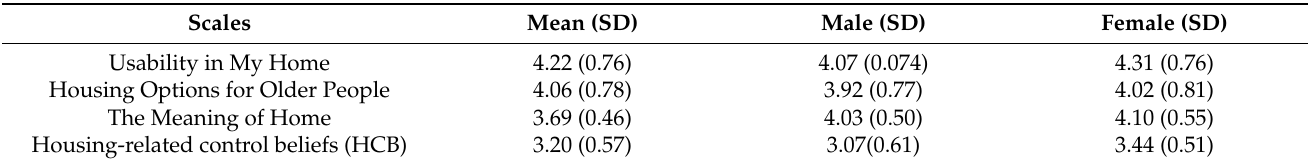
Table 2. Mean and standard deviation of scale of the domains of PH and gender.